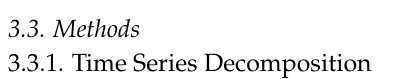
Table 1. The number of crimes of different crime types from February to June in 2020 and 2019, and the rate of crime change in 2020 relative to 2019. Number of Crimes Crime Type (2019) Assault